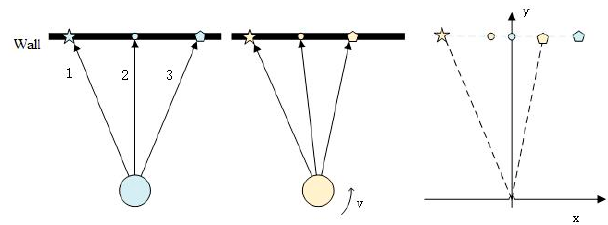
Figure 2. Effect of ego-rotation on scan skewing.